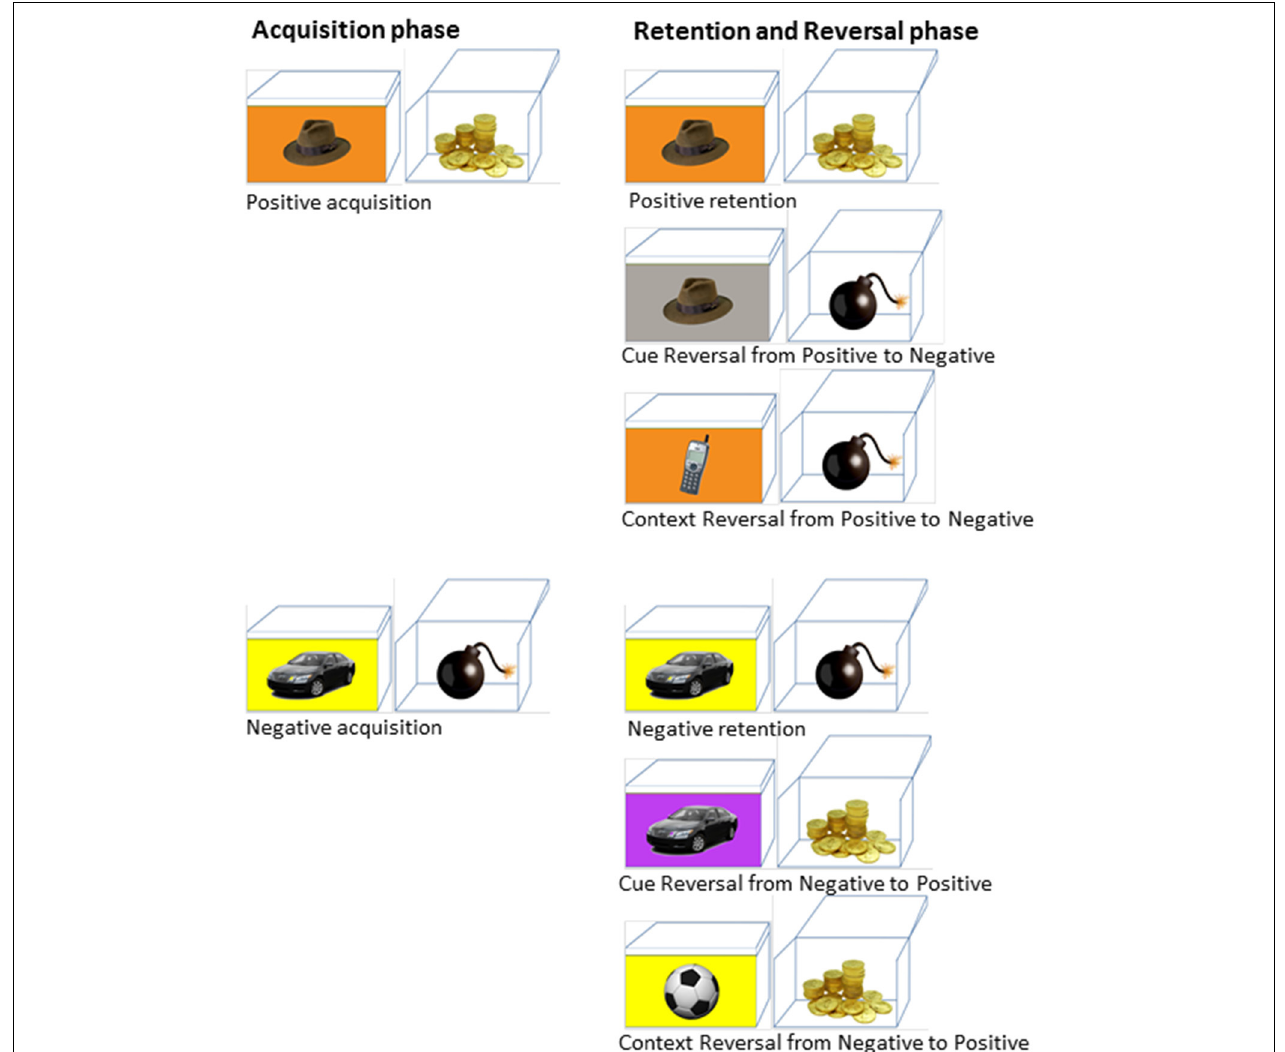
FIGURE 1 | Example of the stimuli in the two phases of the paradigm.